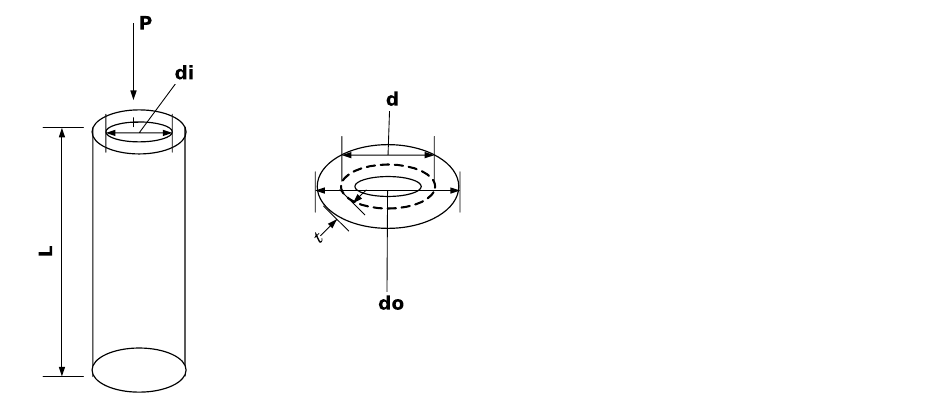
Figure 20. Schematic of tubular column.